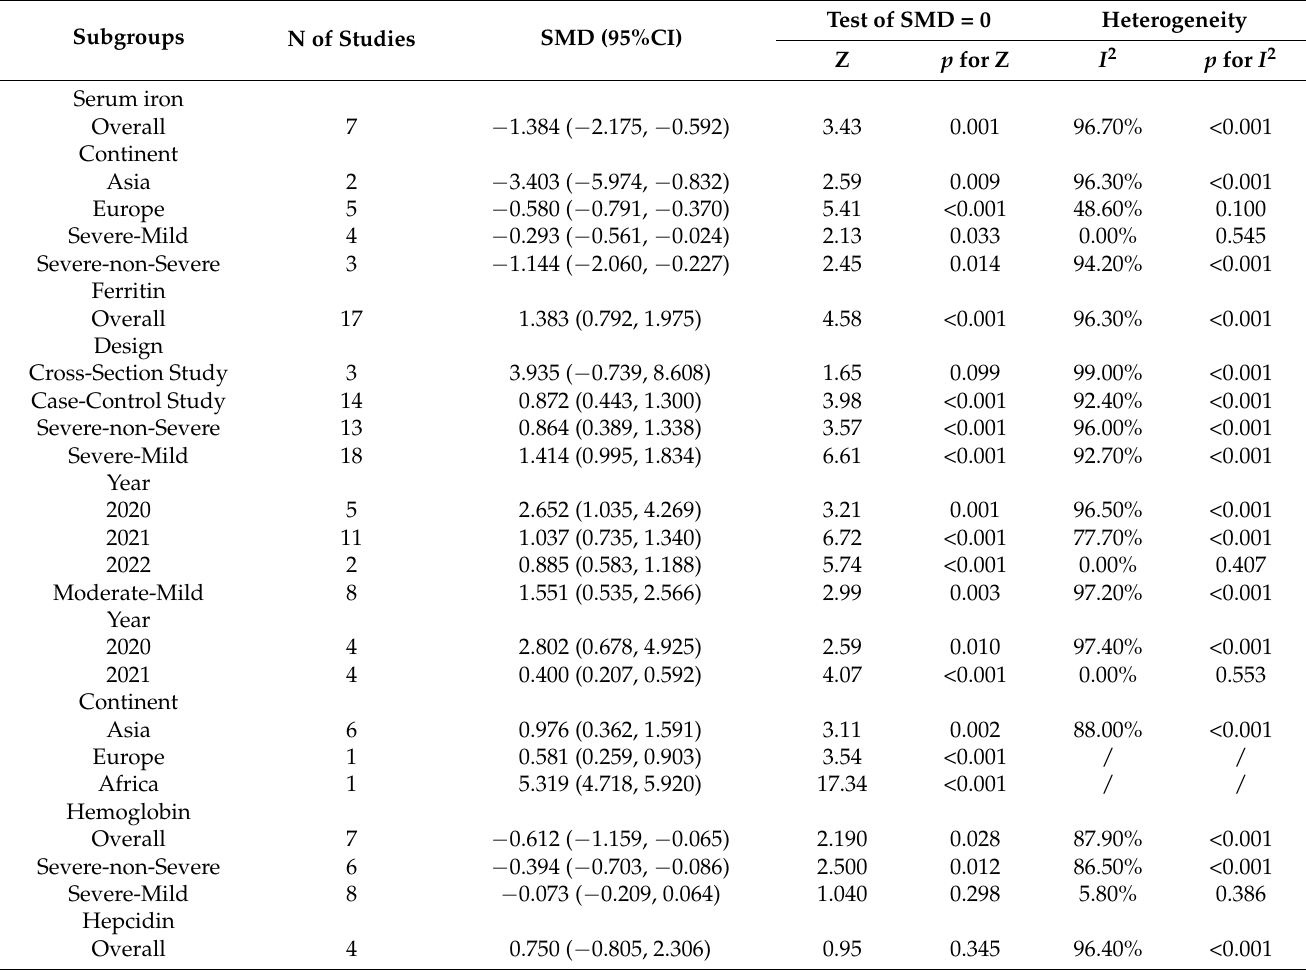
Table 3. Subgroup analyses of studies on the associations of iron-related biomarkers with severity in SARS-CoV-2